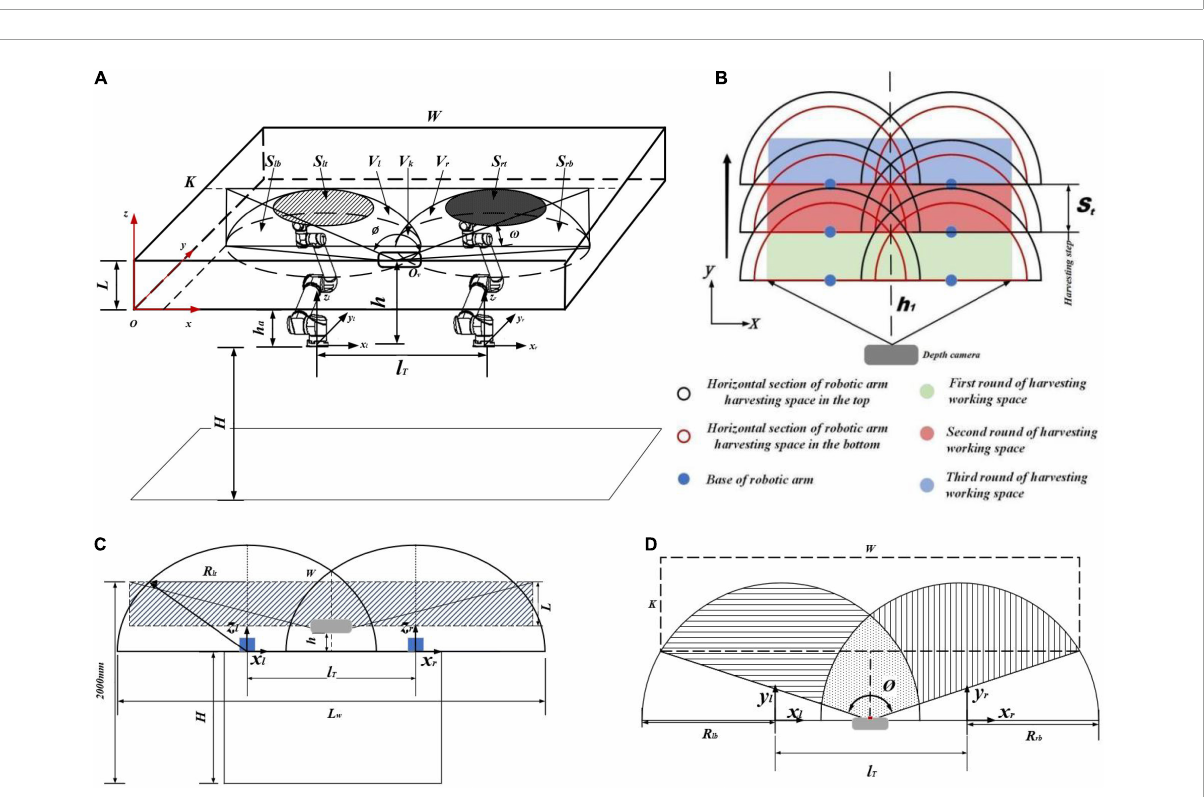
FIGURE6 (A) Analysis of the “one eye-dual arm” working space and camera field of view. (B) Dual-arm working space and robot harvesting step. (C) Operating effect in the XOZ coordinate system. (D) Operating effect in the XOY coordinate